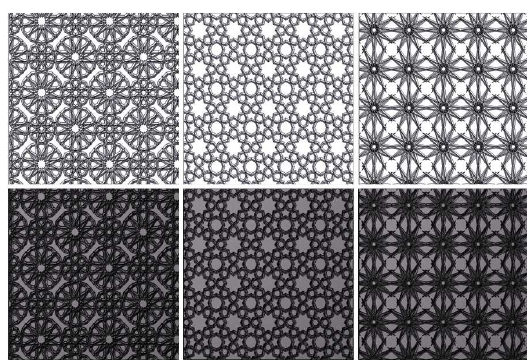
Figure 9. Islamic pattern textures. First, row: height maps. Second row: relighting